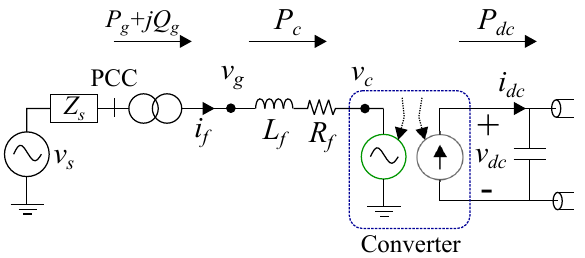
Figure 2. Average VSC